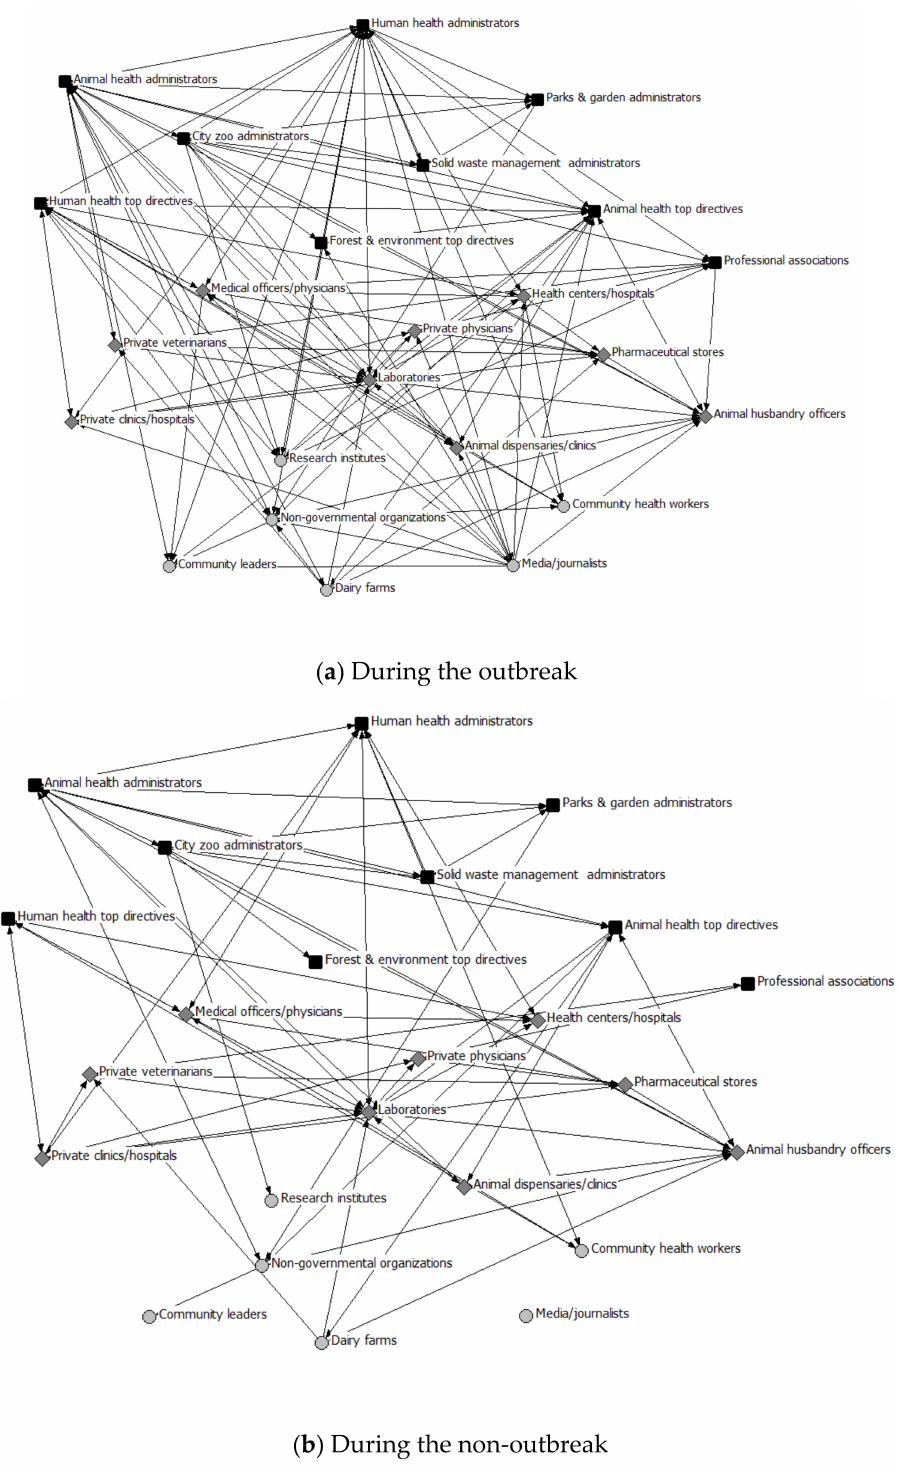
Figure 1. Network view of actors ( a ) during the outbreak and ( b ) during the non-outbreak situations in Ahmedabad, India. Administrative actors: dark-colored squares; Provider actors: medium grey diamond shapes; and Community actors: light grey